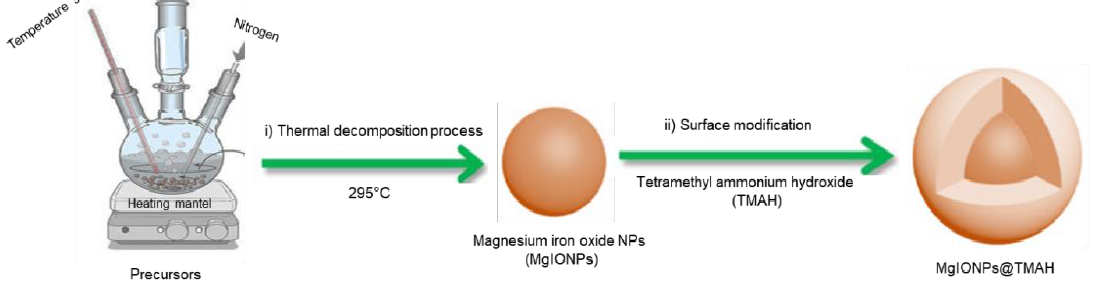
Figure 1. Schematic representation of the steps in the synthesis of MgIONPs@TMAH.